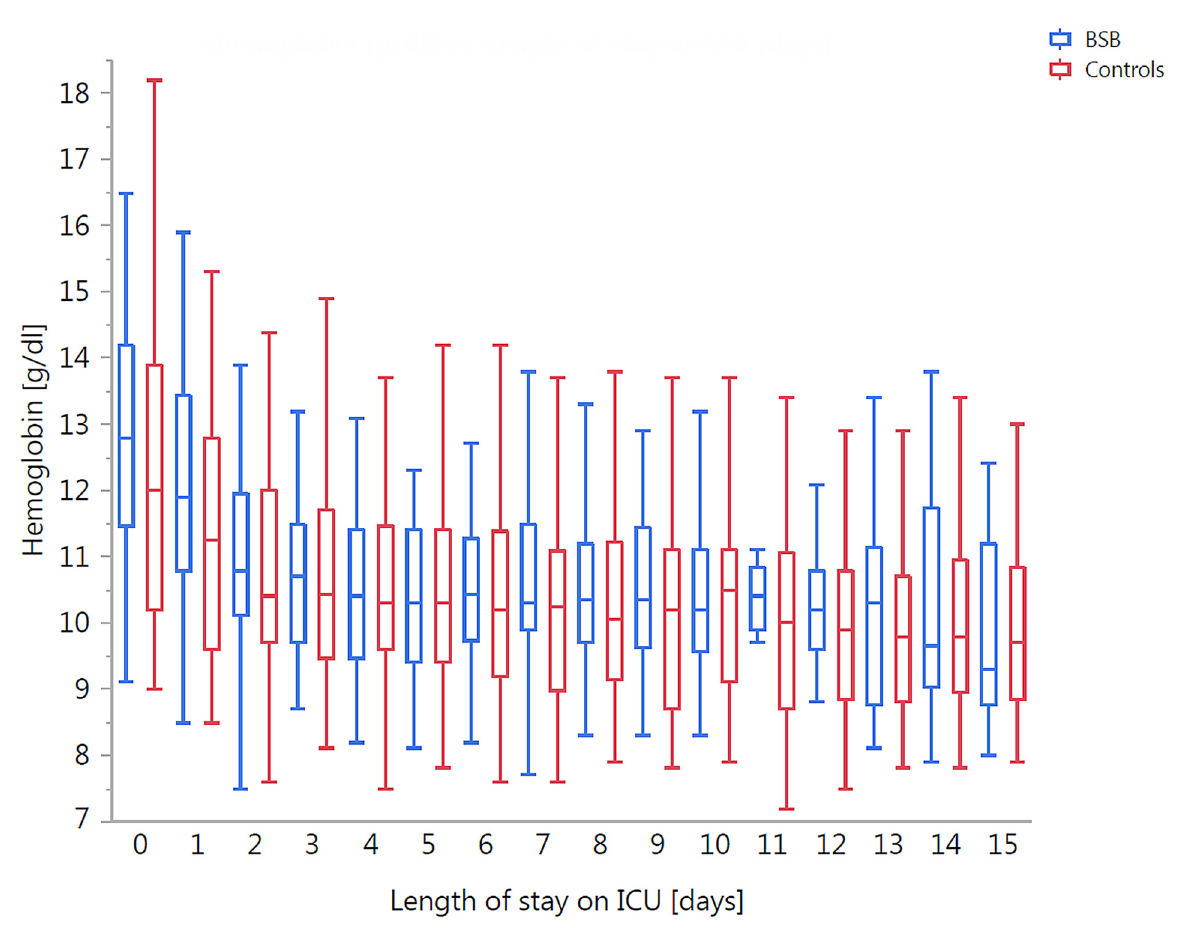
Fig 2. Box plots of the hemoglobin concentrations in the control and BSB group as a function of the length of stay in the ICU. (Note: The box shows the median with the 25 th and 75 th percentiles, and the whiskers indicate the minimum and maximum values.)